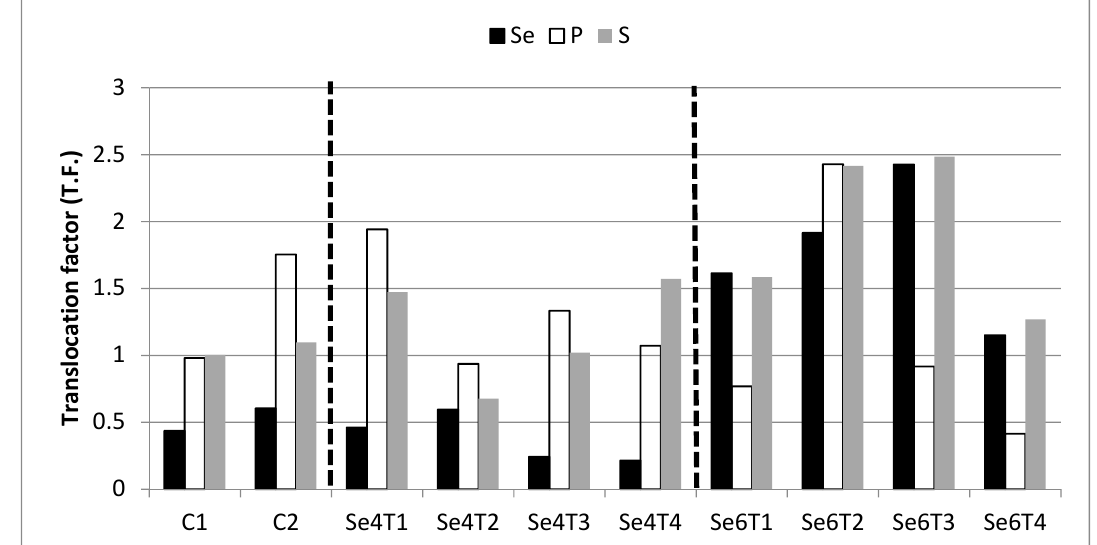
Figure 1. Selenium (Se), sulfur (S), and phosphorus (P) shoot/root translocation factors (T.F.) for controls and treatments. C1: Control without biochar, C2: Control with biochar, Se4: Selenite, Se6: Selenate, T1: 5 mg Se/kg soil without biochar, T2: 10 mg Se/kg soil without biochar, T3: 5 mg Se/kg soil with biochar, T4: 10 mg Se/kg soil with biochar.